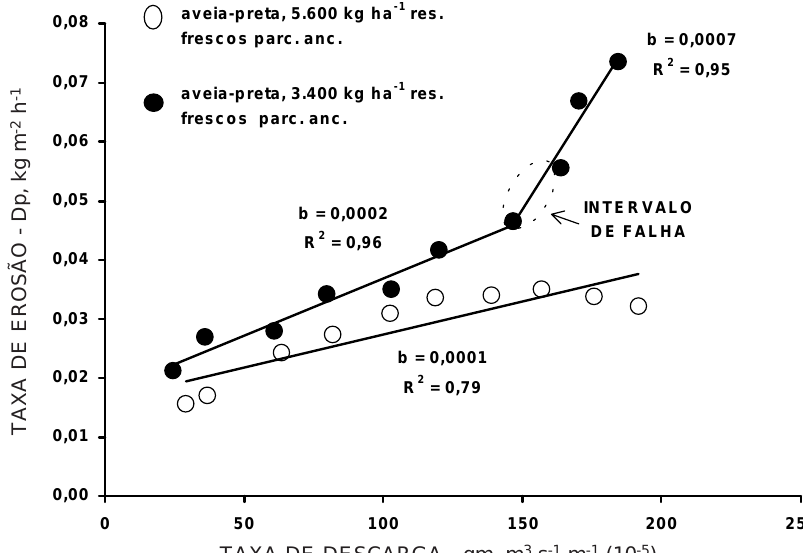
Figura 2. Relação da taxa média de erosão, Dp, com a taxa de descarga no ponto médio da parcela, qm, nos tratamentos com 5.600 e 3.400 kg ha -1 de resíduos de aveia preta, frescos e parcialmente ancorados, no sistema de semeadura direta (Experimento